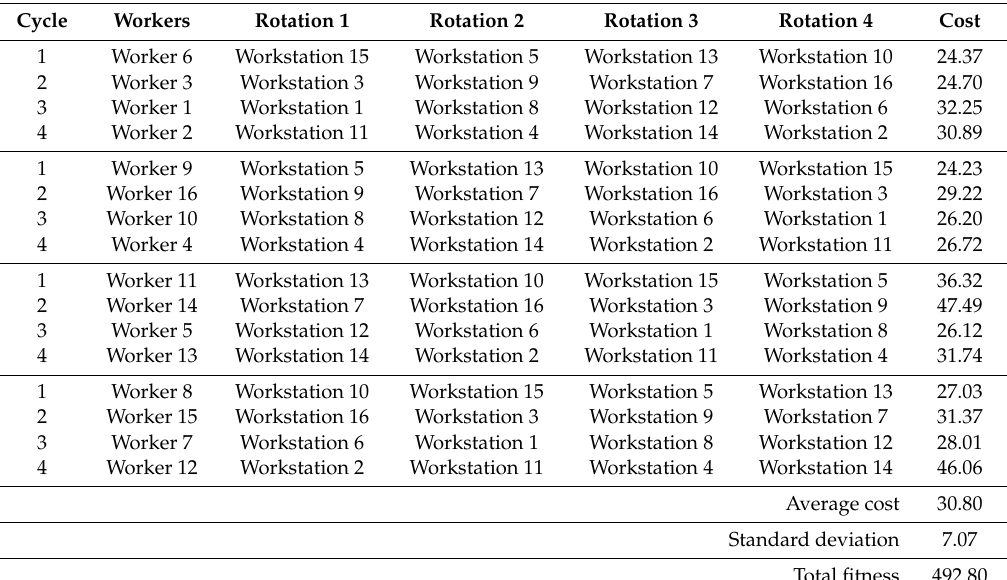
Table 7. Best solution generated by RGA.